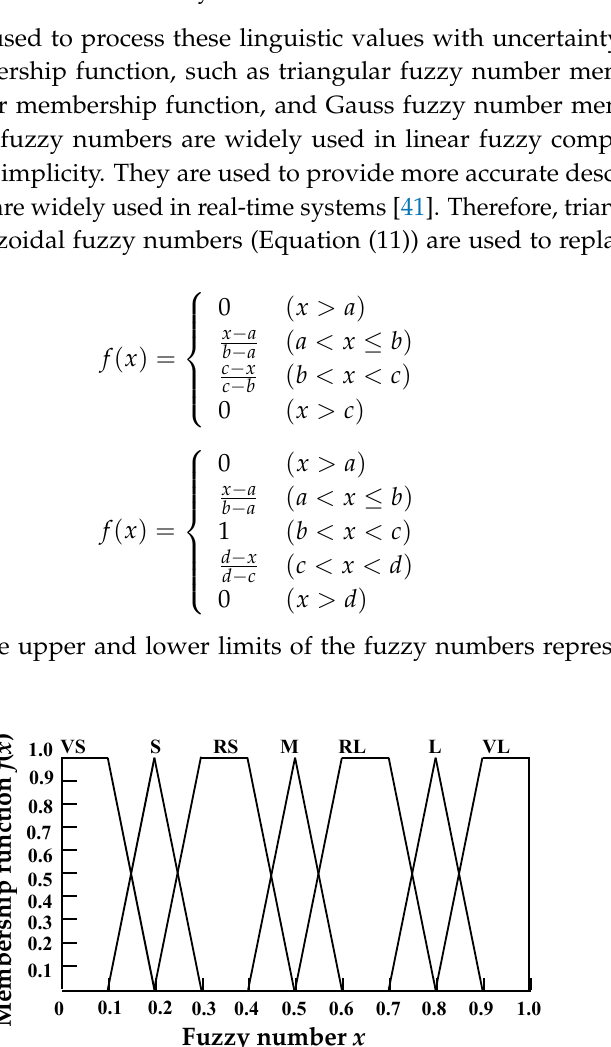
Figure 3. Expert ability assessment analytic model.